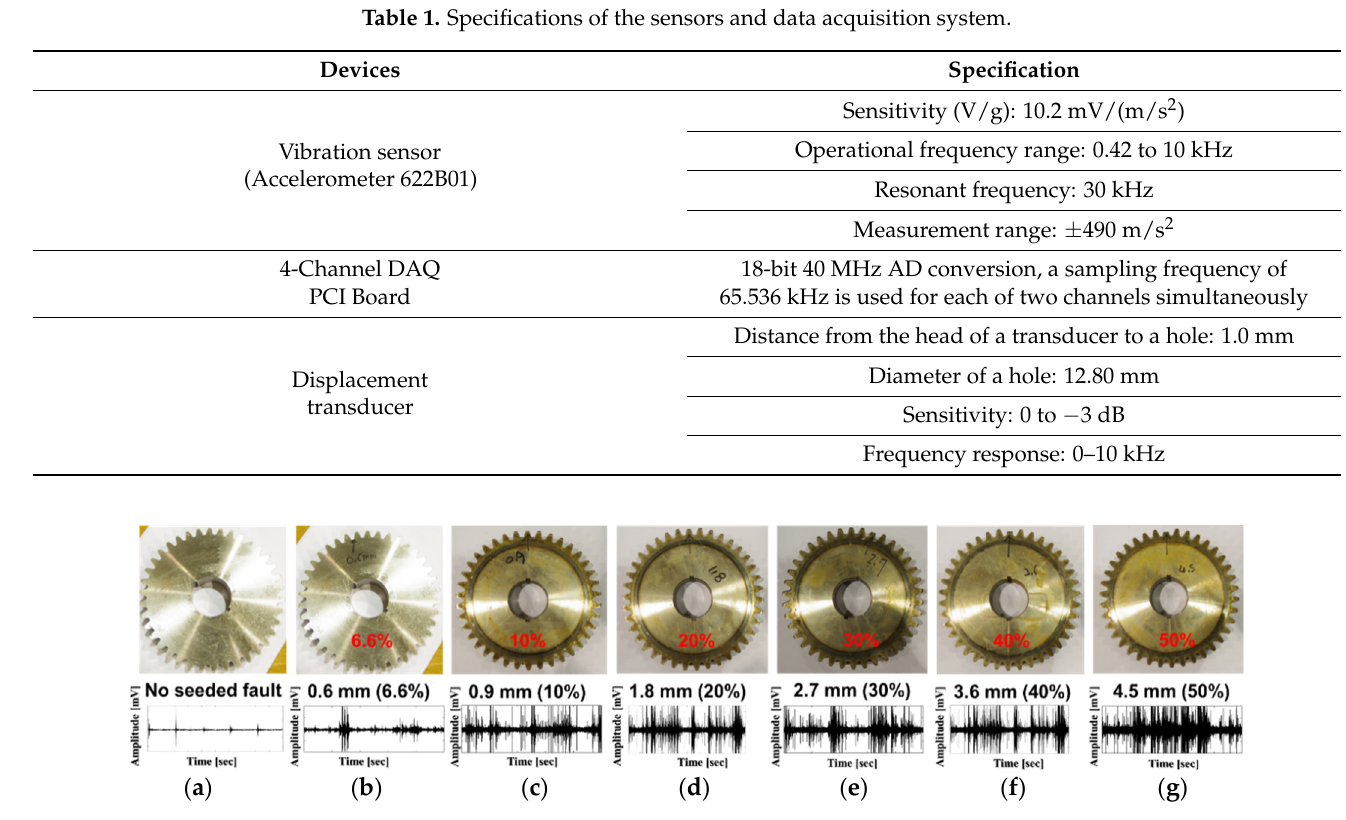
at 600 RPM: ( a ) PC, ( b ) DT1, ( c ) DT2, ( d ) DT3, ( e ) DT4, ( f ) DT5, and ( g ) DT6, respectively.